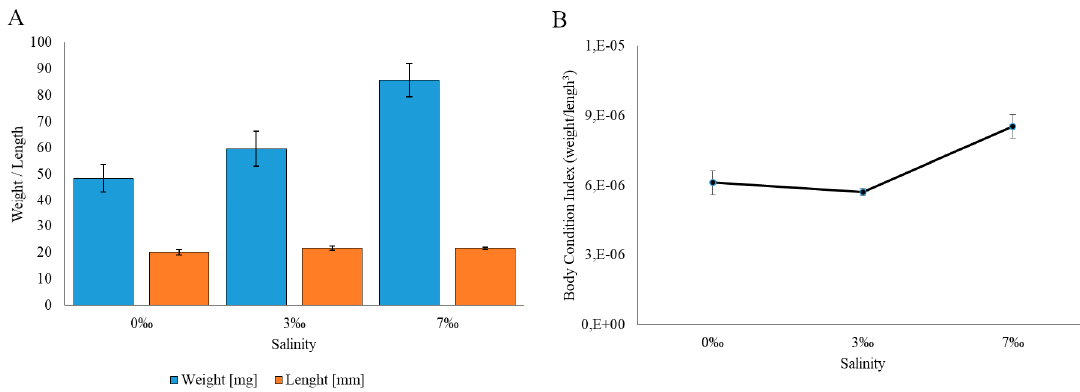
Figure 2. ( A ) Average weight and length of fish at the end of the experiment (n = 20 / group) and ( B ) the e ff ects of salinity on the pike condition index = weight (g) / fork length (mm) 3 ; the mean ± SEM for each salinity level (n = 20).